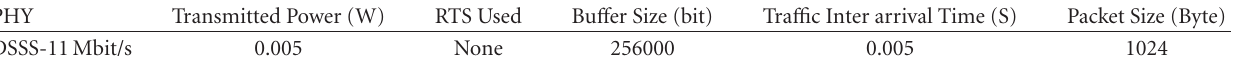
Table 2: Common parameter